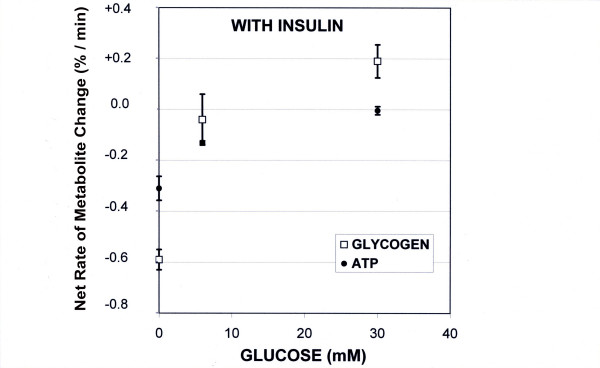
Rates of liver glycogen and ATP changes in presence of insulin in the perfusate. The results are expressed in %·min-1 (mean ± SEM; 100% initial glycogen content = 73 ± 8.5 μmol glycosyl units·g-1 liver wet weight; 100% initial ATP content = 2.60 ± 0.65 μmol/g liver wet weight). The rates of both ATP and glycogen contents increased with the perfusate glucose concentration.